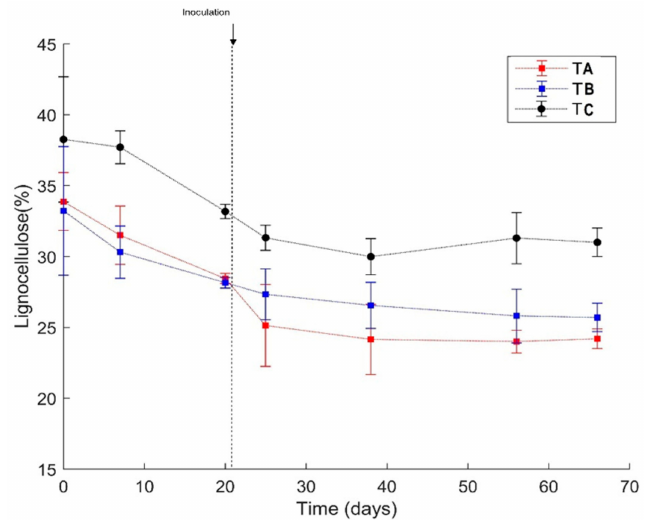
Figure 5. Percentage of lignocellulose in the composting material over